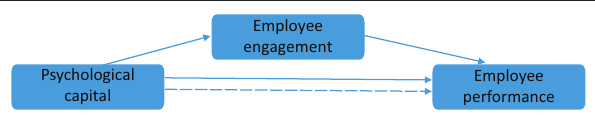
FIGURE 5: Conceptual and research framework 1.